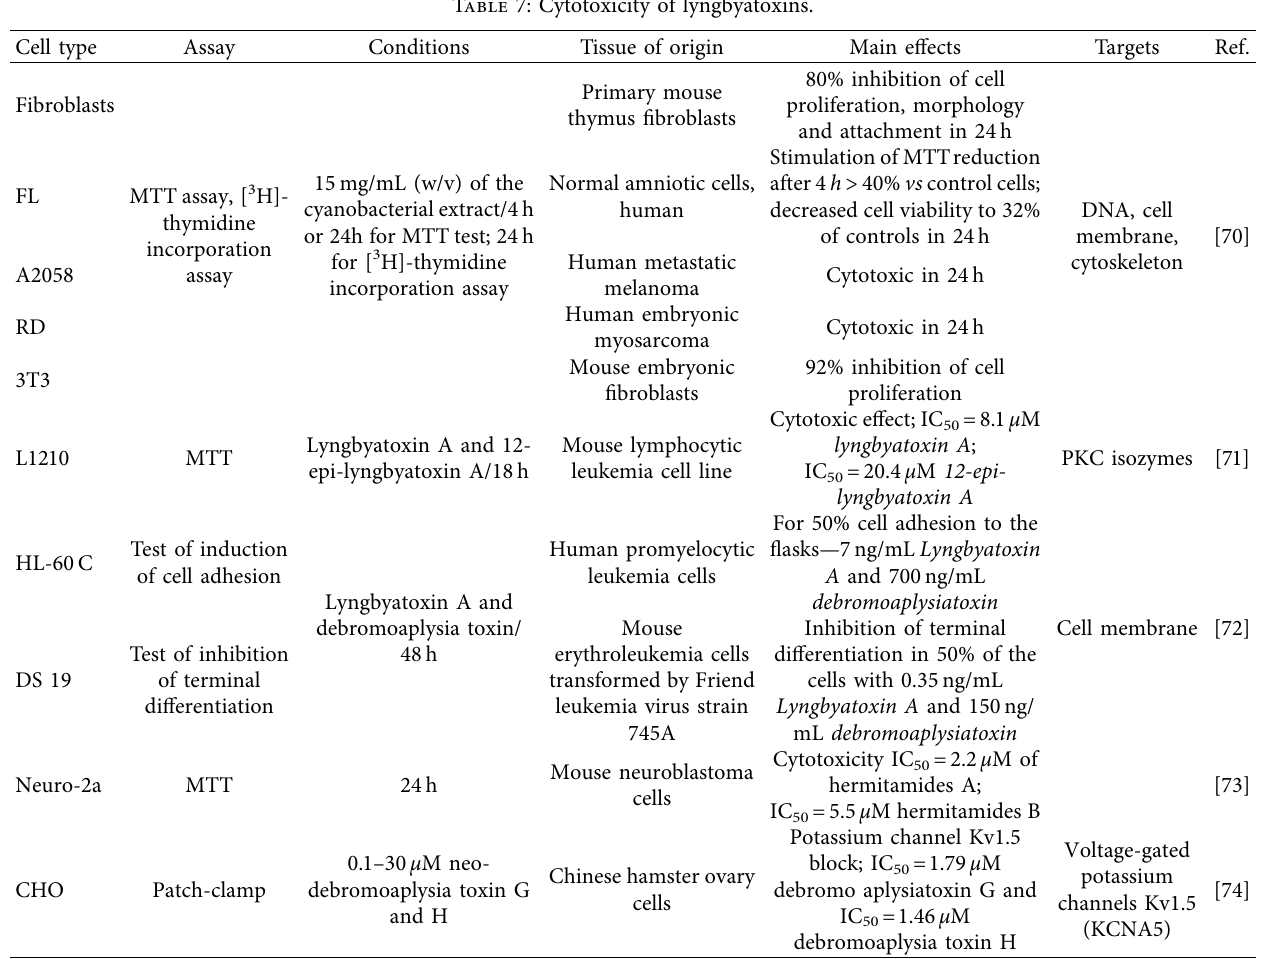
Table 7: Cytotoxicity of